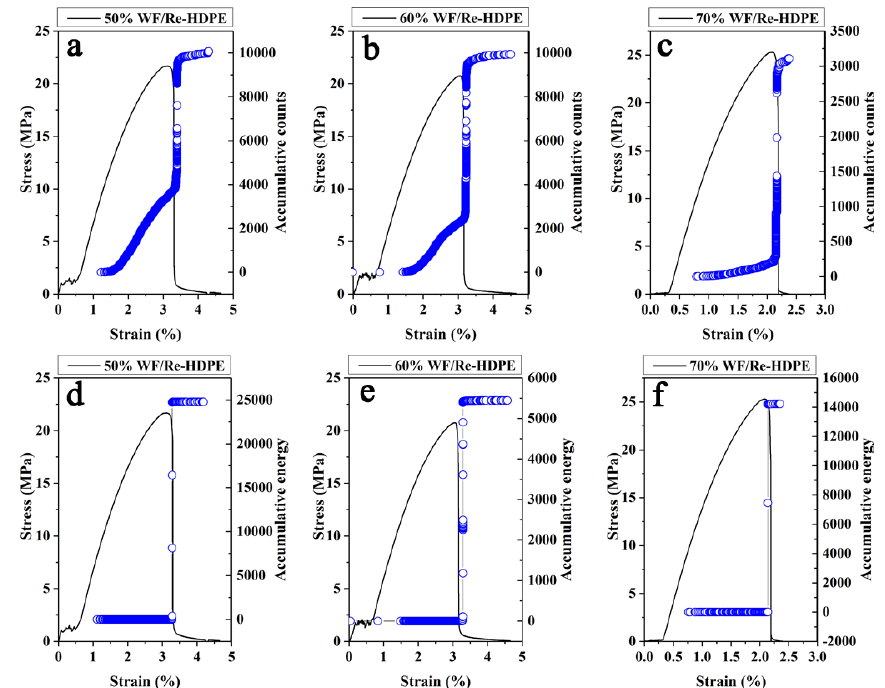
Figure 8. The AE accumulative ringing counts, accumulative energy, and stress-strain curve of WF/Re-HDPE composites with different WF content. The blue circle represents accumulative counts and accumulative energy in Figure 8 a – f , respectively.